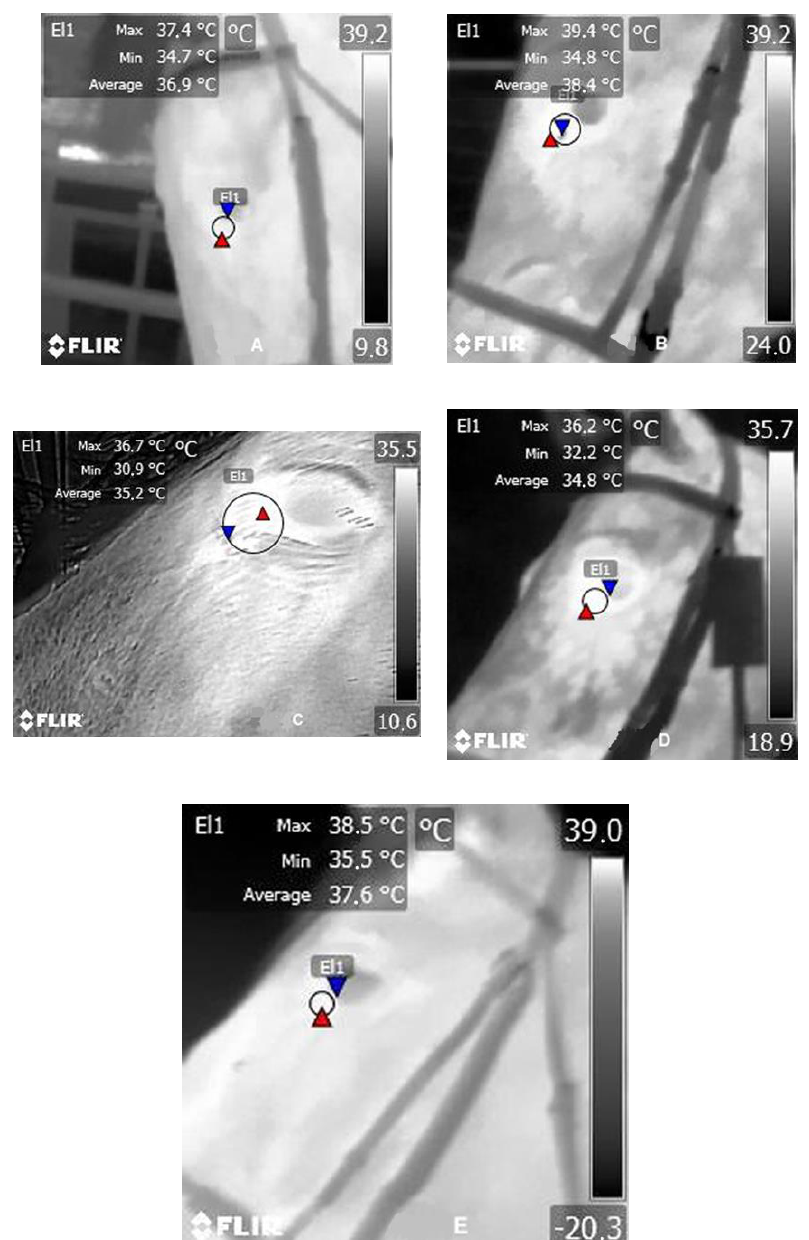
Figure 1. Analyzed eye temperature images of CDE horses according to their genetic line, obtained just after the performance test. ( A ) German genetic line L1; ( B ) Thoroughbred genetic line L2; ( C ) Trotter genetic line L3; ( D ) Pura Raza Española genetic line L4; ( E ) Other Breeds genetic line L5. Where, El1 is a selected area from the thermographic image (indicated with a circle); indicates the maximum temperature point; and indicates the minimum temperature point.